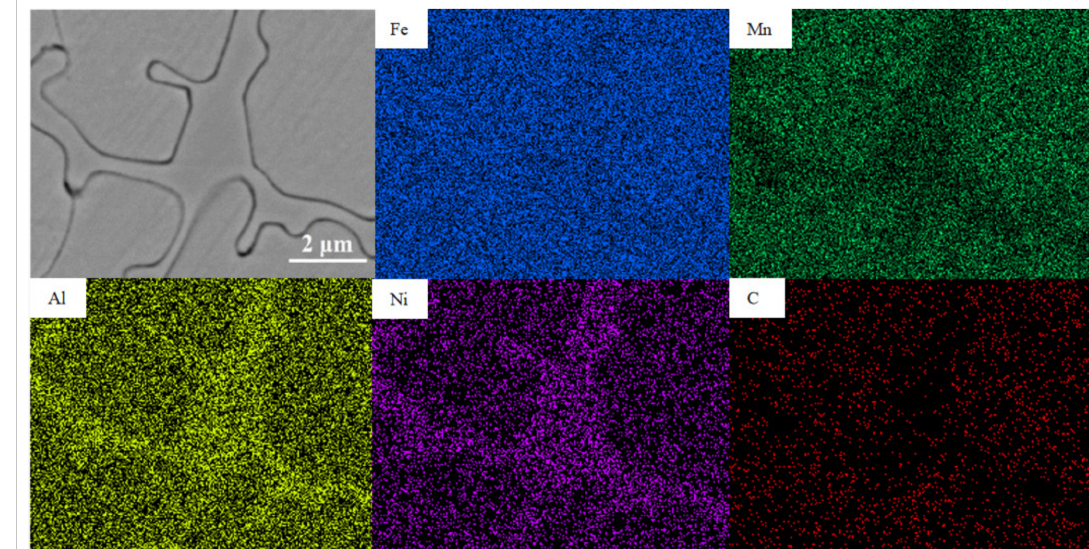
Figure 4. Element surface scanning analysis of Fe-25Mn-12Al-8Ni-C alloy. The phase in Fe-25Mn-10Al-8Ni-C alloy was analyzed by TEM, and the microstructure